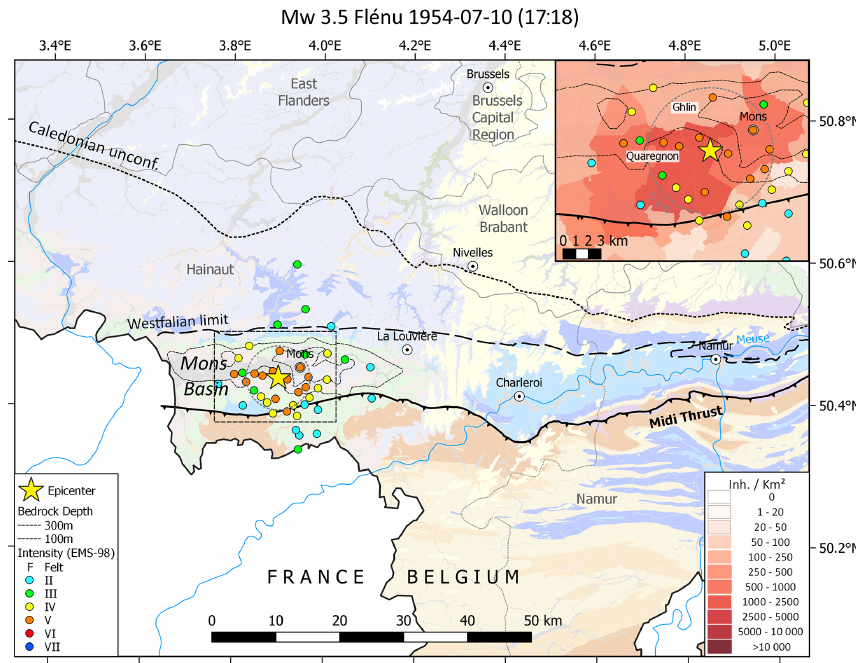
Figure B3. Macroseismic map of the 1954 M w = 3 . 5 earthquake in Borinage (no. 16 in Table 1). Maximal intensity = V. Geology in the background based upon http://www.onegeology.org/. Reproduced with the permission of © OneGeology. All rights reserved. The inset shows the population